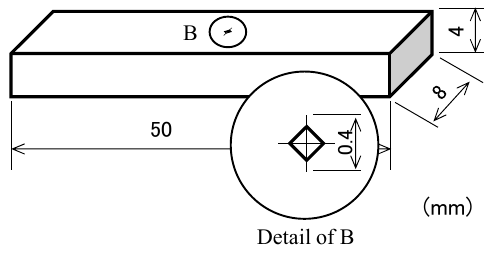
Figure 4. Notched specimens used for investigating the FCG rate of short surface cracks at R = 0.1.